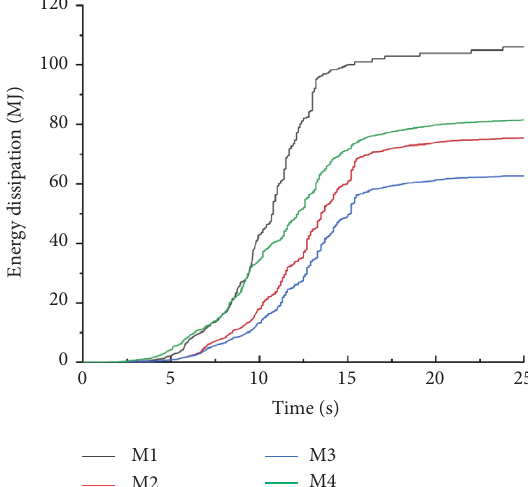
Figure 16: Comparison of energy dissipation of different